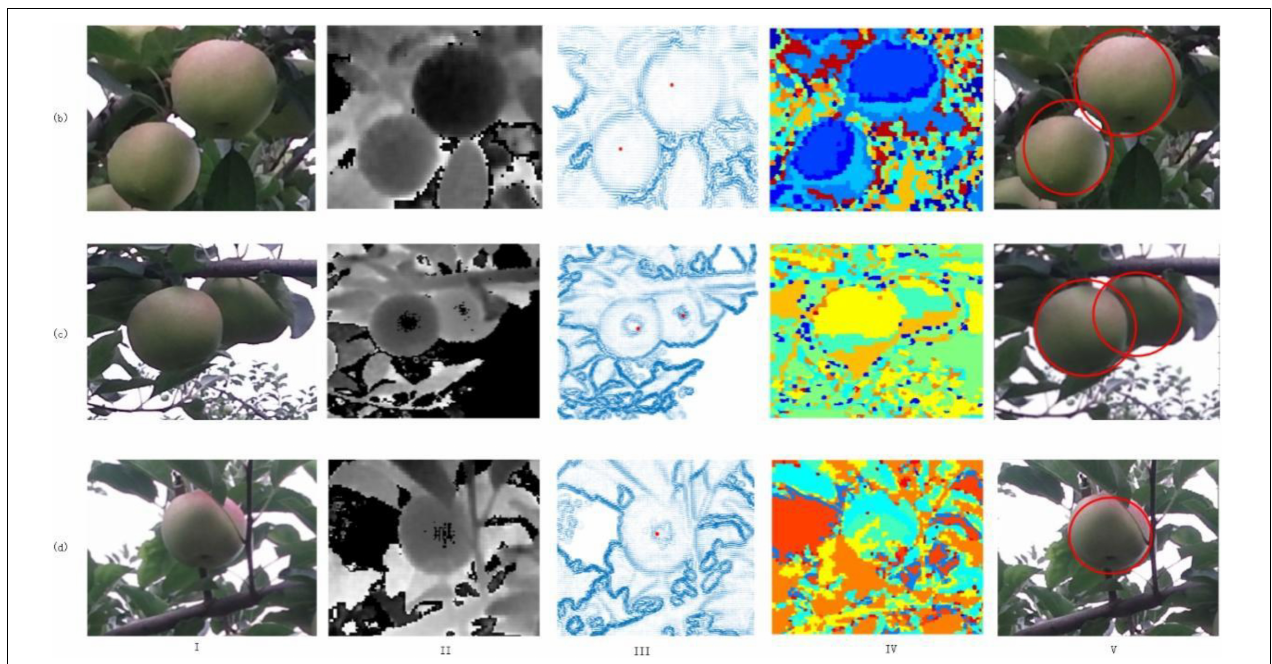
FIGURE 15 | Three types of target fruit recognition and location effect (I) RGB space image, (II) depth image, (III) center position effect image, (IV) segmentation rendering, (V) identify and location.